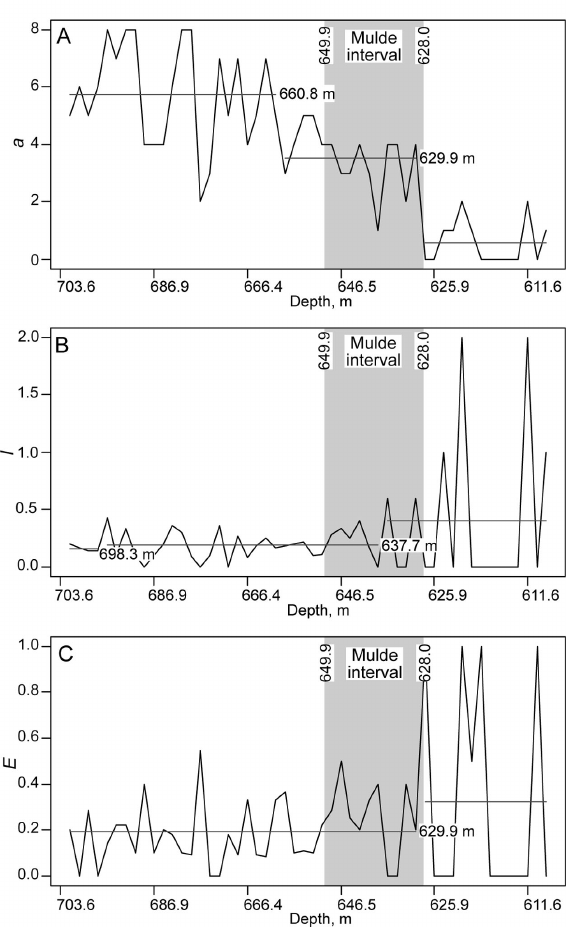
Fig. 4. Changepoint analyses of conodont palaeoecological time series in the Ledai-179 core section. A , stratigraphic series of local species richness estimates ( a ); B , dynamics of per capita immigration rates ( I ); C , dynamics of per capita extirpation rates ( E ). Dashed horizontal lines denote statistically differing dynamic